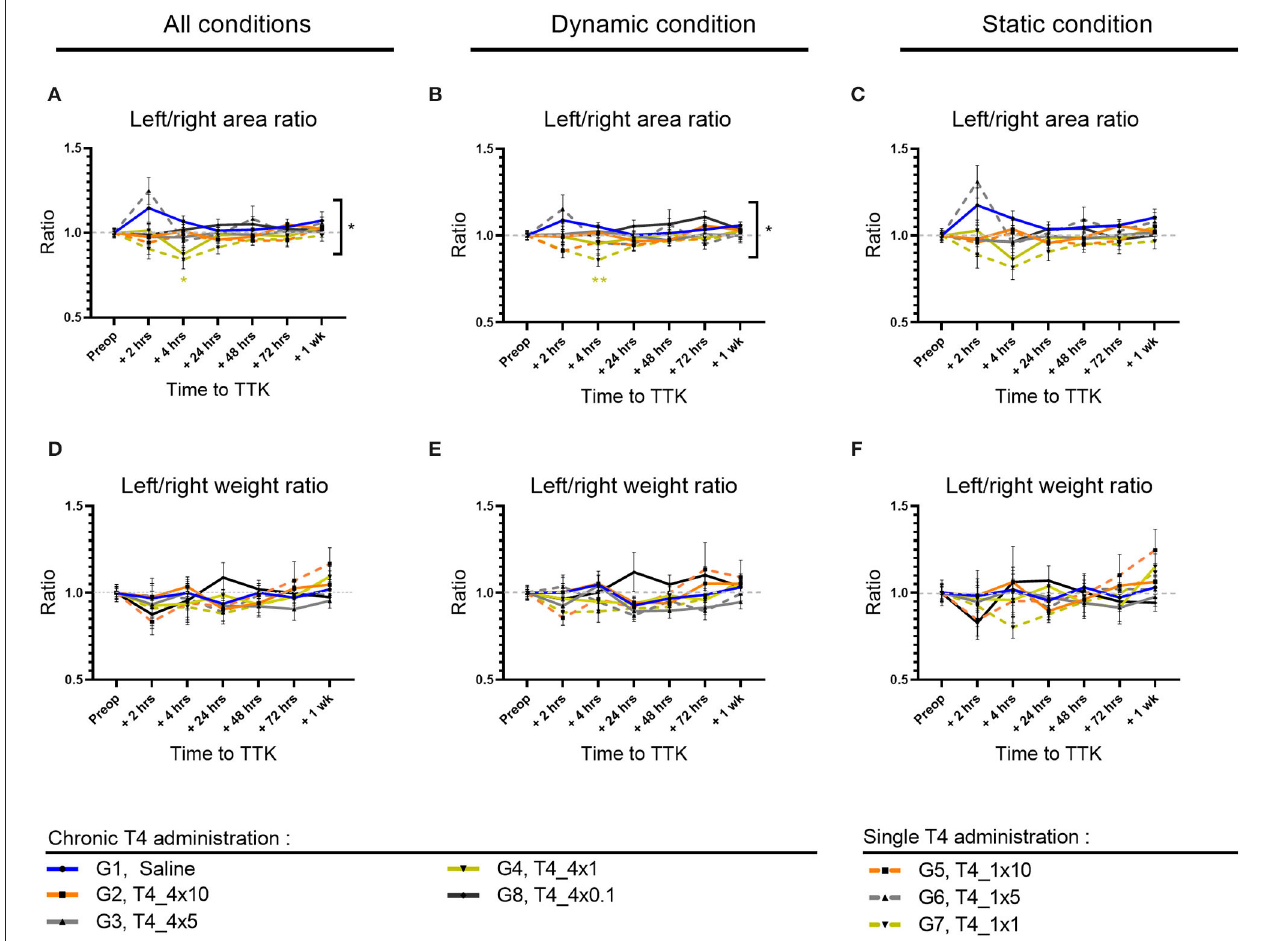
FIGURE 4 | Effect of T4 treatment on left/right area (A–C) and weight (D–F) ratio in vestibular defective rats. Postural balance is assessed for all postures (A,D) or under dynamic (B,E) or static conditions (C,F) . Statistically significant differences are assessed using two-way Anova with Tukey post-hoc , * p < 0.05, ** p < 0.01. n = 114.